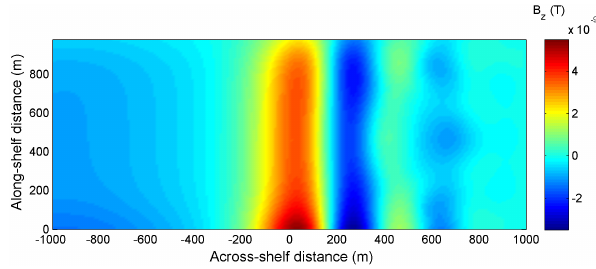
Figure 13. Internal wave signature in the induced magnetic field ( z component) at 1m depth, at time t =